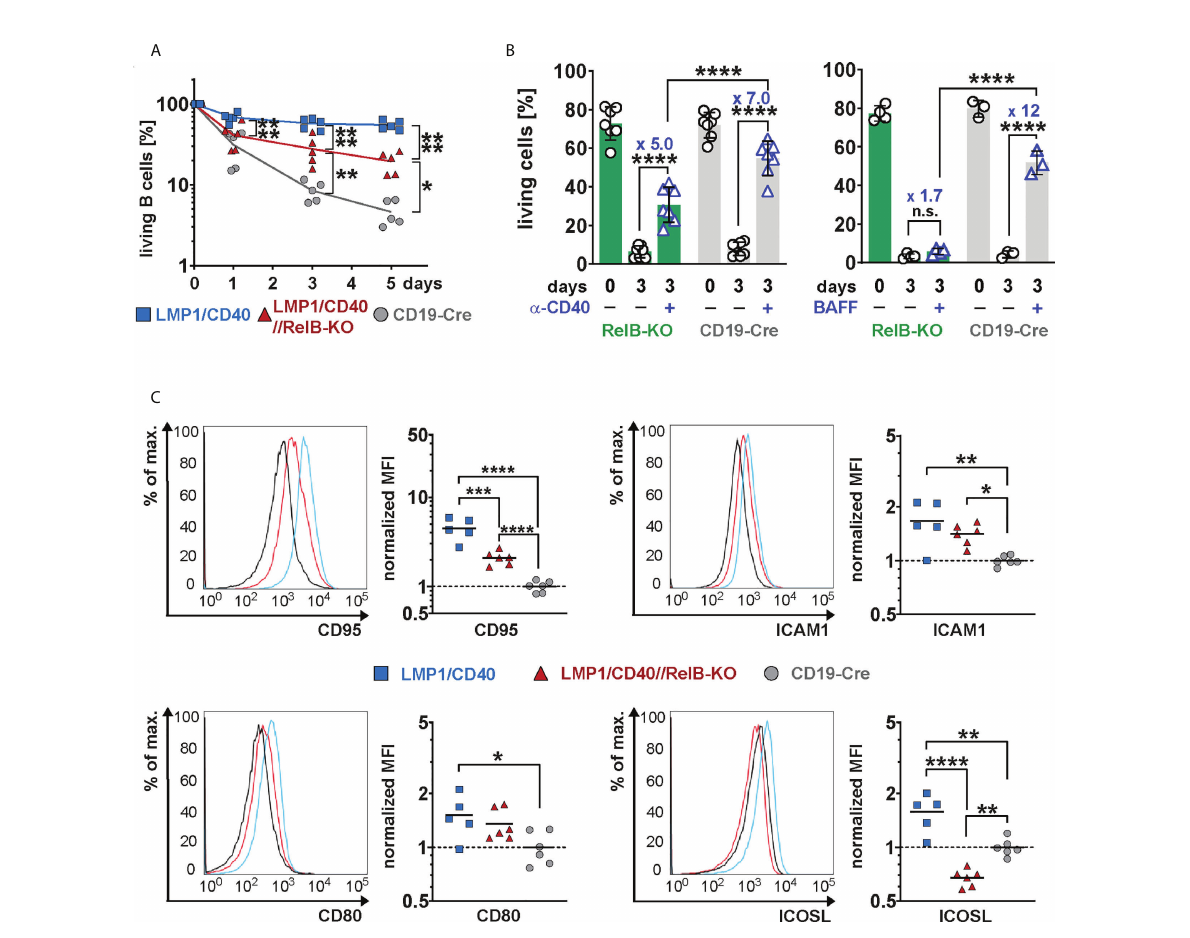
FIGURE 4 Impaired survival and activation of CD40-stimulated B cells in the absence of RelB: (A) Splenic B cells from mice with the indicated genotypes were cultured for up to 5 days in vitro . On days 0, 3 and 5, the percentage of live cells (TO-PRO-3 − ) was determined by FACS. N =5 independent experiments. An ordinary two-way ANOVA, Tukey´s multiple comparisons test was performed. (B) Splenic B cells from the indicated genotypes were stimulated for 3 days with an agonistic anti-CD40 antibody or BAFF or were kept unstimulated. Indicated are the percentages of live cells (TO-PRO-3 − ). The graph compiles the percentages of live cells on day 0 and day 3 from N =7 (anti-CD40) and N ≥ 3 (BAFF) independent experiments. Statistical analysis was performed with an ordinary two-way ANOVA, Sidak´s multiple comparisons test. (C) Surface expression of the indicated activation markers was determined by FACS. For each marker, one representative histogram overlay is shown. The histograms are pre-gated on live lymphocytes and CD19 + cells. The graphs summarize the mean fl uorescence intensities (MFI) of the indicated surface markers in the indicated genotypes from N ≥ 5 independent experiments. The average of the MFI of the controls was used to normalize each sample. Due to their log normal distribution, values were logarithmized before calculating the statistics with an ordinary one-way ANOVA with Tukey ’ s multiple comparison. P-values in (A – C) * P<0.05, ** P<0.01, *** P<0.001, **** P<0.0001. (B, C) Symbols represent values from individual mice, and the lines or bars indicate